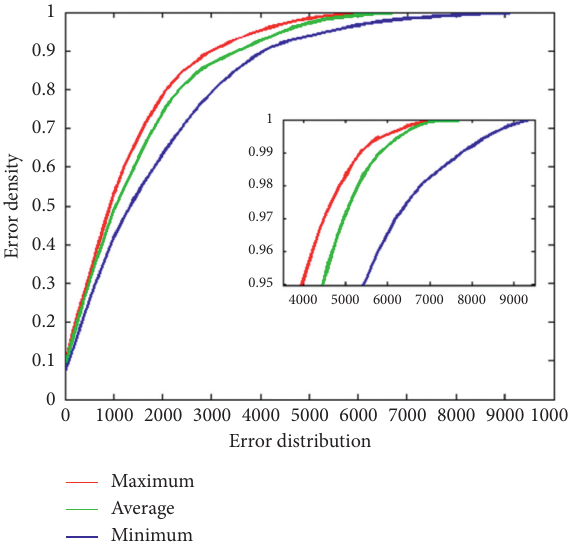
Figure 6: Performance of SMOTE